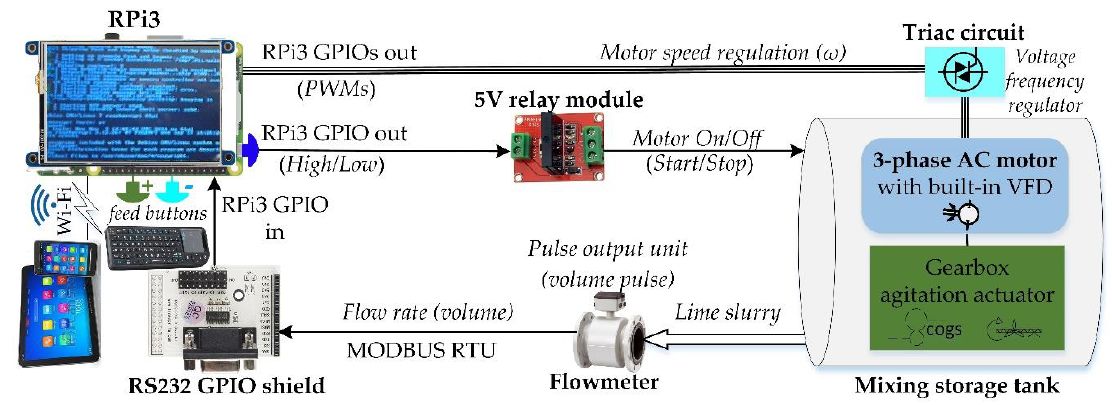
Figure 8. COTS-based control system.